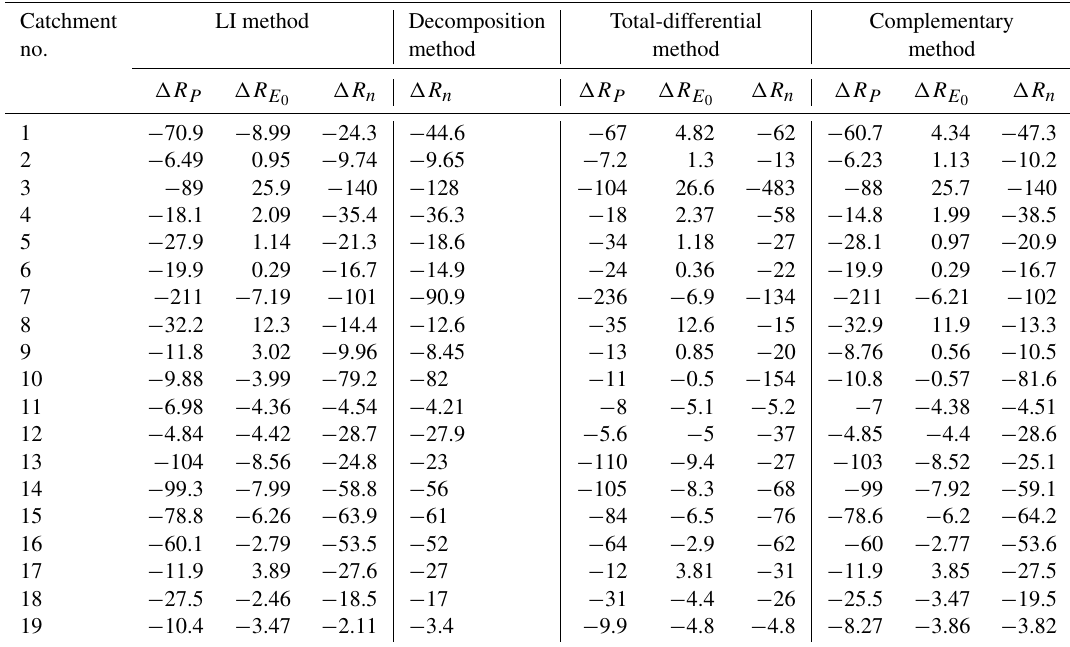
Table 3. Effects of precipitation ( (cid:49)R P , 10 − 3 myr − 1 ), potential evapotranspiration ( (cid:49)R E 10 − 3 myr − 1 ) on the mean annual runoff determined from the four evaluated